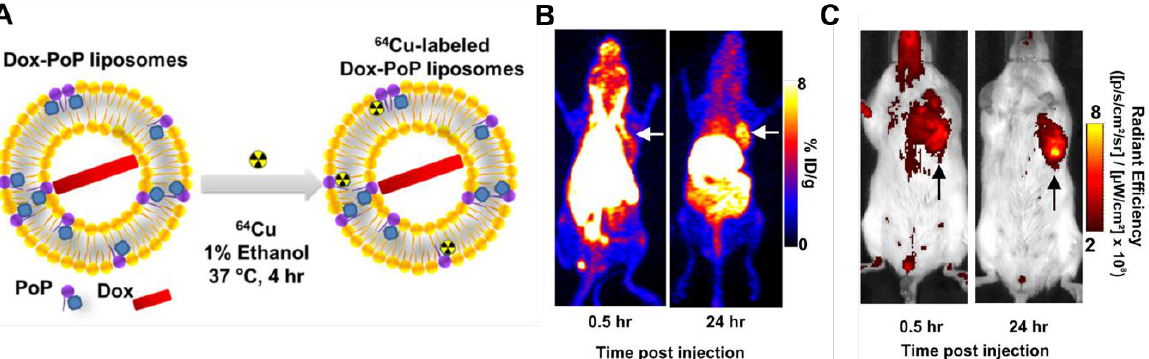
Figure 13. ( A ) Doxorubicin-loaded Cu-porphyrin-phospholipid liposomes. ( B ) PET scan of mice after administration of DOX-CuPoP. ( C ) NIR Fluorescence imaging of mice after administration of DOX-CuPoP. Reprinted with permission from [134]. Copyright 2017 American Chemical Society.